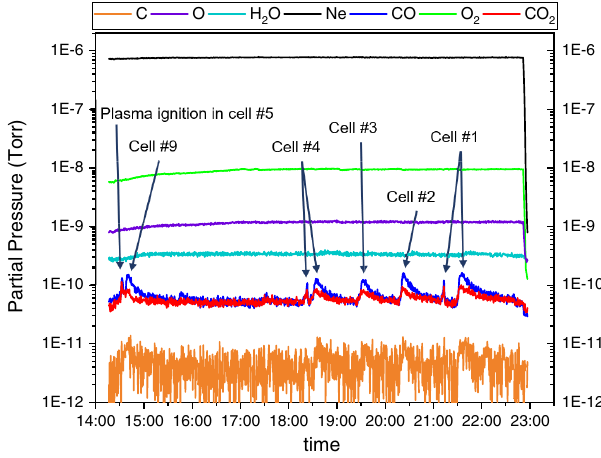
FIG. 7. Example of RGA plot acquired during the first day of plasma processing of a nine-cell cavity. Cell # 4 and cell # 1 exhibit a double peak due to the plasma being accidentally turned off while reaching the desired plasma